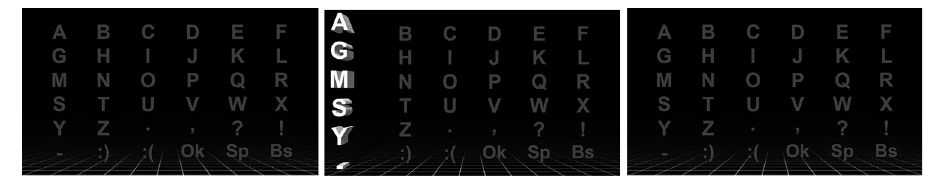
Fig 4. Three-dimensional column-based experiment paradigm with duration.